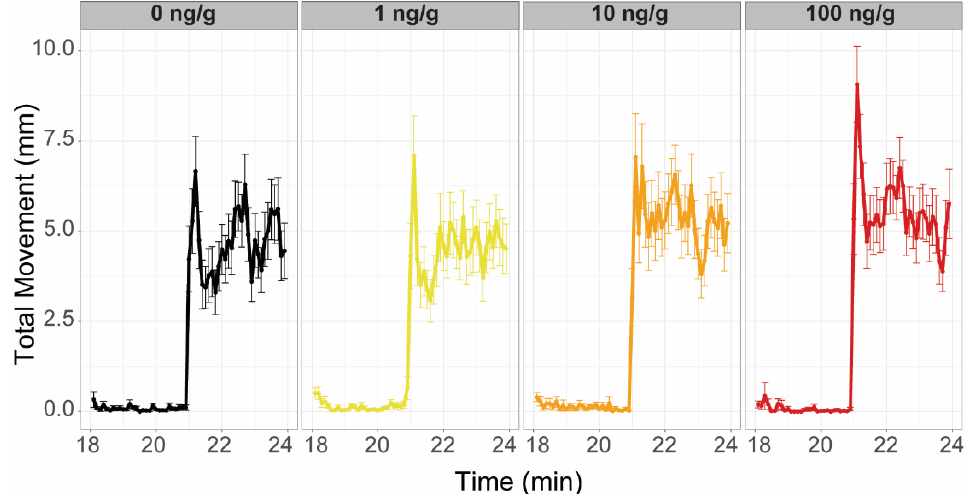
Figure 6. F1 Larval Photomotor Response. Plots represent one of the evaluated F1 zebrafish cohorts and are representative of both evaluated cohorts (120 hours post fertilization). Exposure groups are indicated on the top of each panel and by color (left to right, grey: 0 ng/g, yellow: 1 ng/g, orange: 10 ng/g, and red: 100 ng/g PFHxA added to the F0 diet). In each panel, the first 3 min were the final light period (lower total movement), while the last 3 min were the final dark period. The 10 ng/g group exhibited significant hyperactivity in the dark period relative to controls ( n = 48).